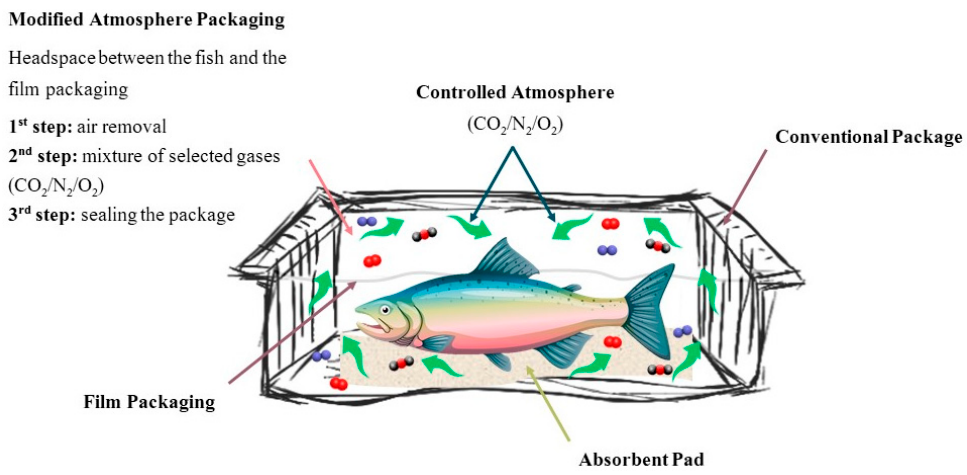
Figure 2. Schematic representation of MAP technology applied to fishery products.